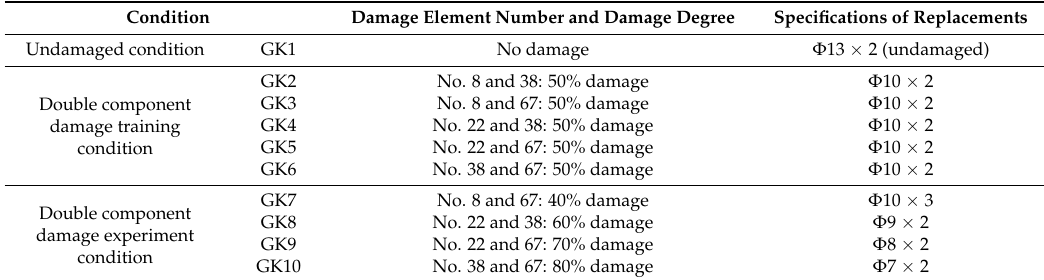
Table 4. The damage and undamaged conditions.